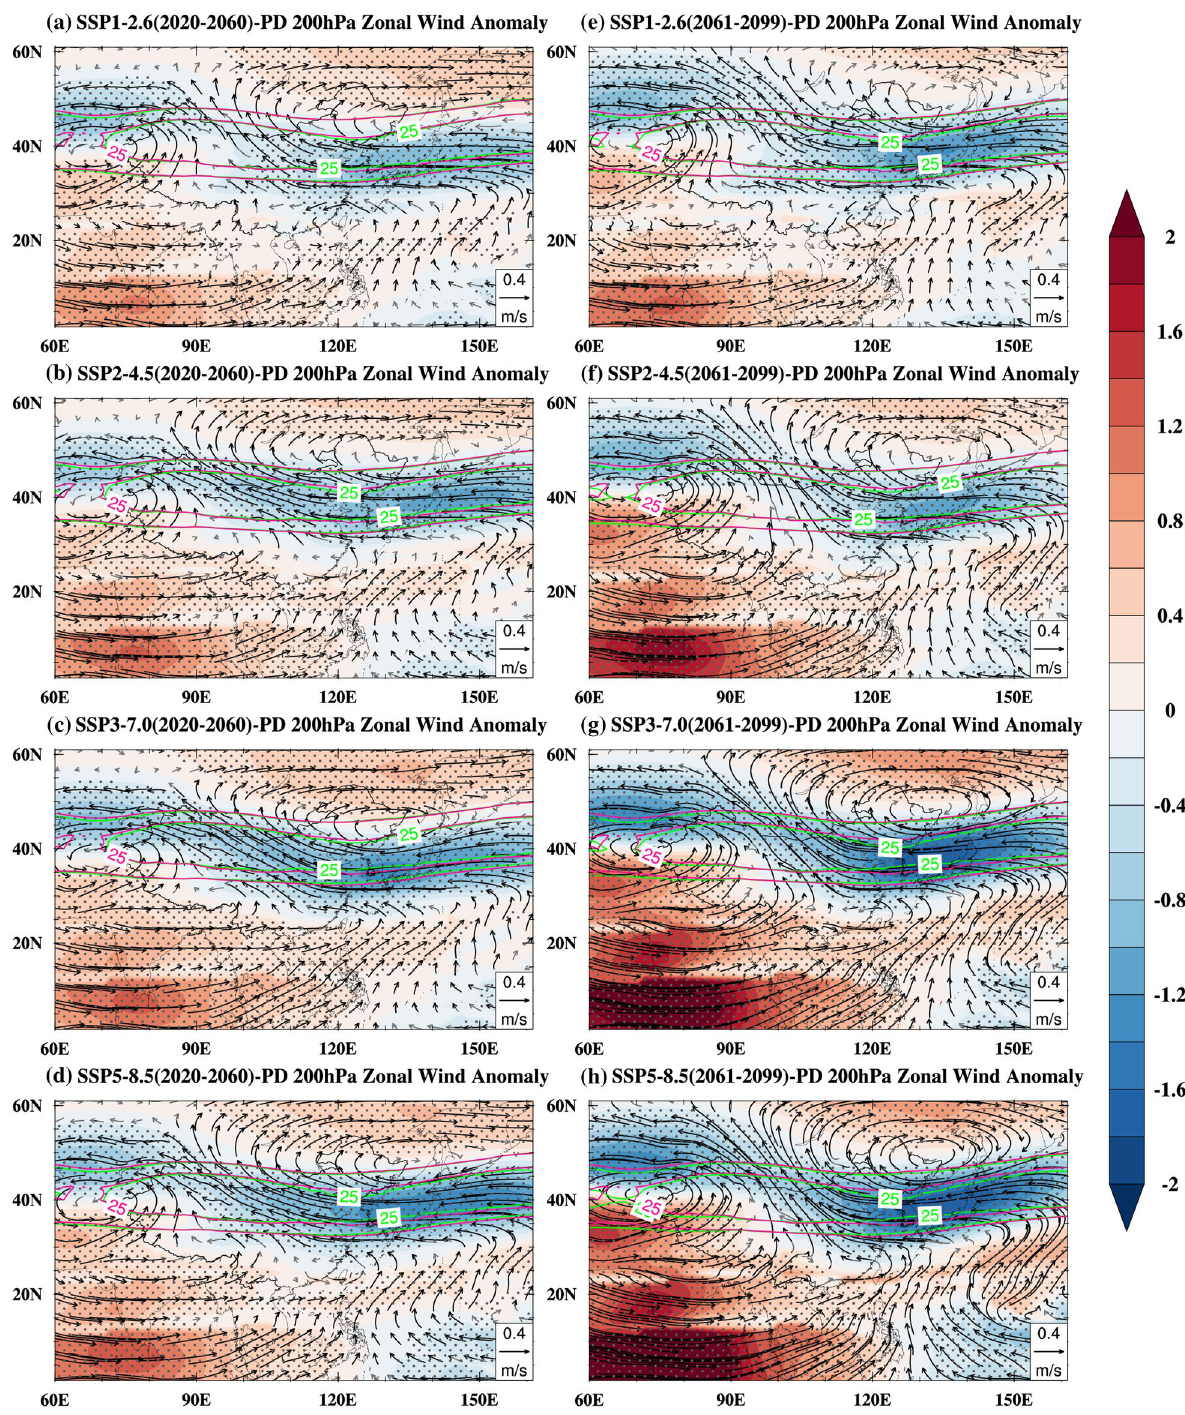
Figure 8. Summer 200 hPa zonal wind (unit: m/s, shading) and wind anomalies (unit: m/s, vector) for 2020–2060 (near-term, a – d ) and 2061–2099 (late-term, e – h ) under the SSP1-2.6 ( a , e ), SSP2-4.5 ( b , f ), SSP3-7.0 ( c , g ), SSP5-8.5 ( d , h ) relative to the present day, together with the climatologic mean of the East Asia subtropical westerly jet (unit: m/s) for the future (red contours) and the present day (green contours). The black vectors and dots indicate a 5% of significance level. Maps were generated using the NCAR Command Language (The NCAR Command Language (Version 6.6.2) [Software]. (2019). Boulder, Colorado: UCAR/NCAR/CISL/TDD. https:// www. ncl. ucar. edu/ Downl